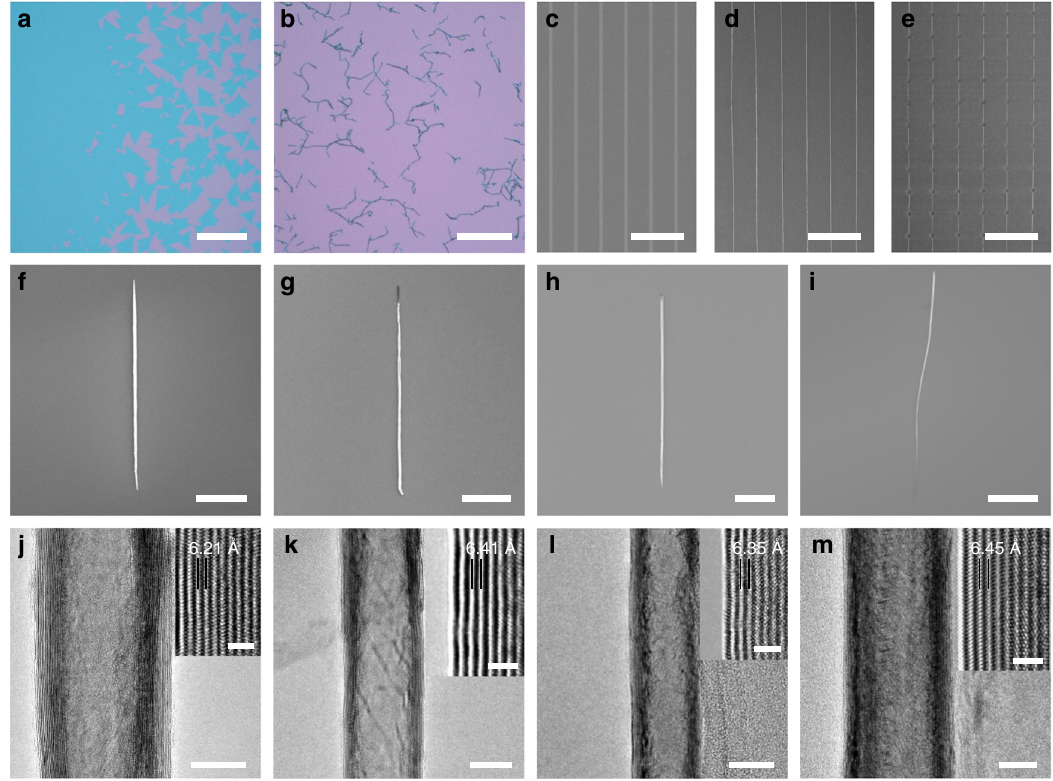
Fig. 2 Transition metal dichalcogenide (TMD)-nanoscrolls (NSs) from self-scrolling chemical vapor deposition (CVD)-based TMD monolayer fl akes. a Optical image of CVD-grown MoS 2 monolayer fl akes on a SiO 2 /Si substrate (the purple area represents the substrate, the green area represents the MoS 2 monolayers; scale bar, 500 μ m). b Optical image of MoS 2 -NSs on a SiO 2 /Si substrate (scale bar, 100 μ m). c – e The fabrication process of a MoS 2 -NS array (scanning electron microscopy — SEM image shown, scale bars, 50 μ m). c Large-area MoS 2 monolayer fi lm patterned into ribbons by focused ion beam (FIB) etching (the dark region represents MoS 2 fi lm, the bright area is bare substrate). d Long MoS 2 -NSs made from the controllable scrolling of the patterned MoS 2 fi lm in c . (The white parallel lines are MoS 2 -NSs, and the dark area represents the substrate). e A 12 × 6 array of MoS 2 -NSs fabricated via a second FIB etching of the long MoS 2 -NSs in d . f – i SEM images of typical TMD-NSs on SiO 2 /Si substrates: MoS 2 -NSs ( f ),WS 2 -NSs ( g ), MoSe 2 -NSs ( h ), and WSe 2 -NSs ( i ). (Scale bars, 5 μ m in f , i and 10 μ m in g , h ). j – m TEM images of typical TMD-NSs: MoS 2 -NSs ( j ),WS 2 -NSs ( k ), MoSe 2 -NSs ( l ), and WSe 2 -NSs ( m ). (Scale bars, 20 nm). Inset: High-magni fi cation images of sidewalls of TMD-NSs (scale bars, 2